Question: How would you classify this visualization?
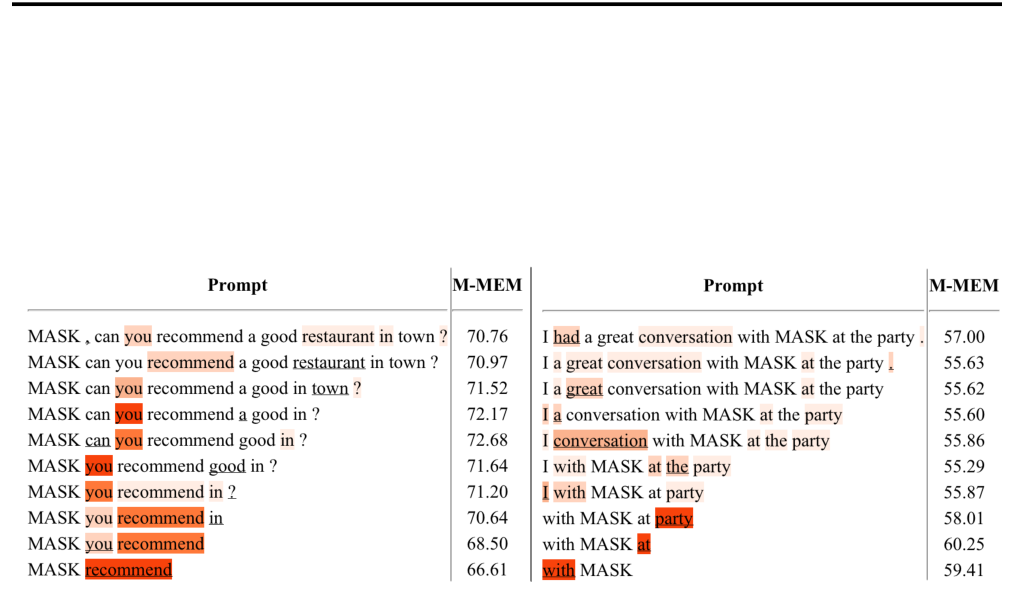
Answer: heatmap